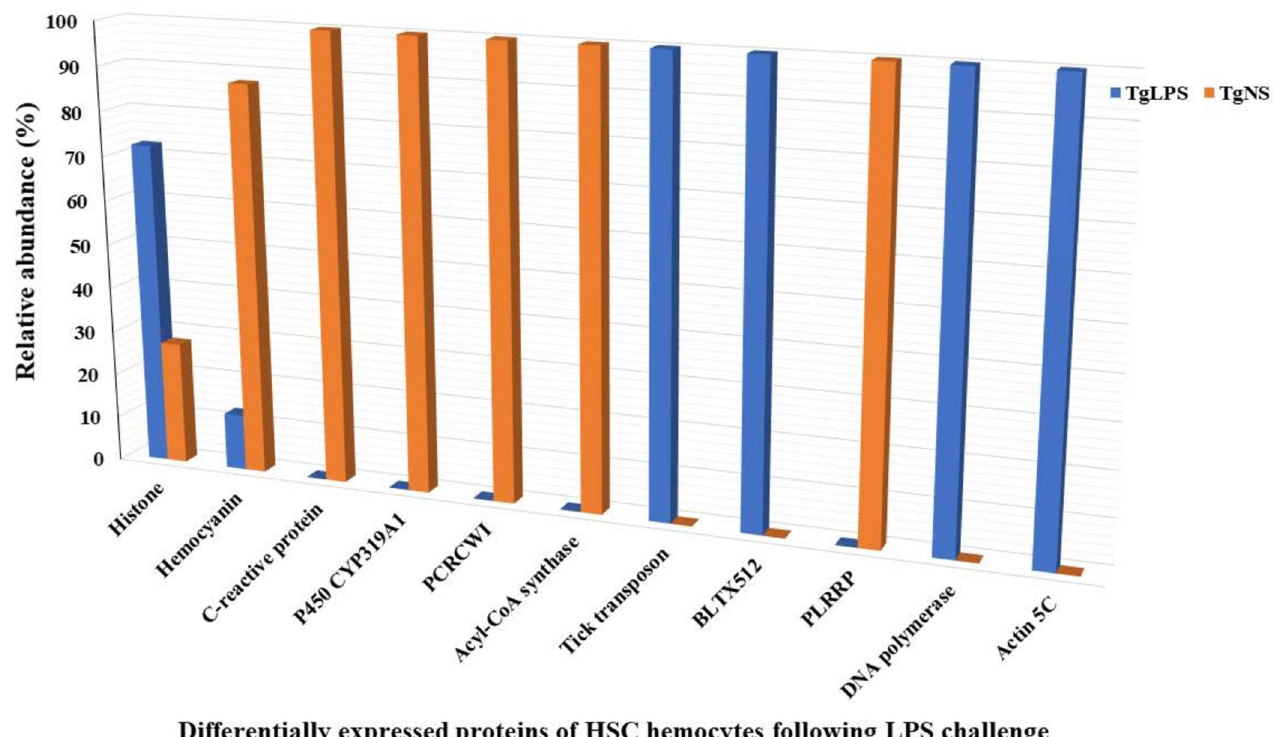
Fig 4. T . gigas proteins that are differentially expressed after LPS challenge. As displayed in the figure, the expression/abundance of proteins of the hemocytes of T . gigas were altered which signify the effect of the LPS challenge (mimics of bacterial infection). PCRWI- putative chromatin remodeling complex wstf-iswi, PLRRP- putative leucine-rich repeat protein. TgNS, non-stimulated T . gigas hemocytes and TgLPS, lipopolysacharride-stimulated T . gigas